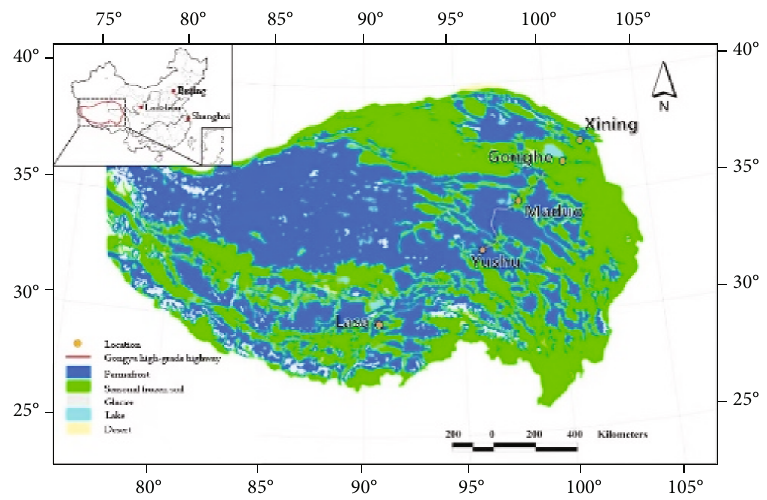
Figure 1: Distribution permafrost along the Gongyu high-grade highway.